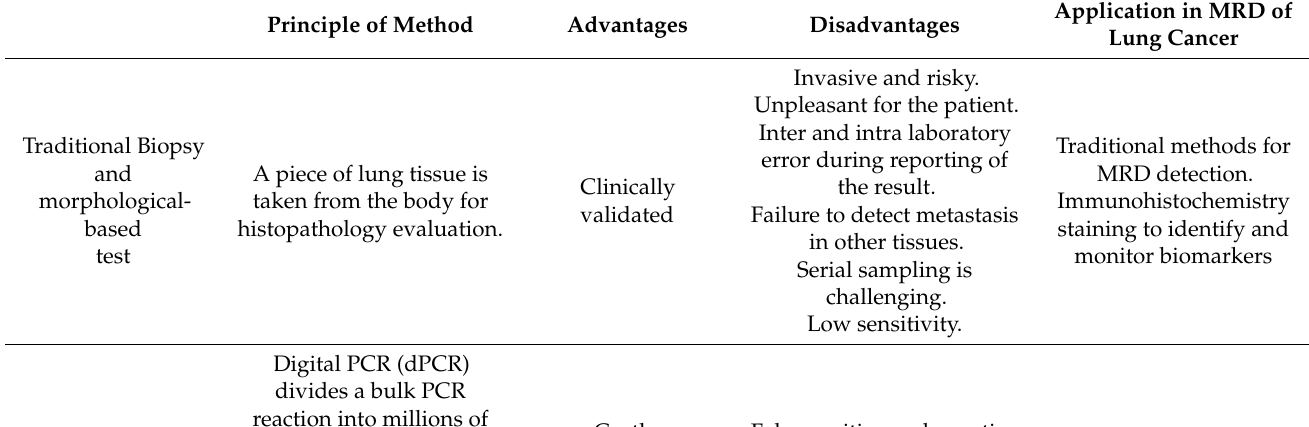
Table 1. Advantages and disadvantages of routine MRD methods in